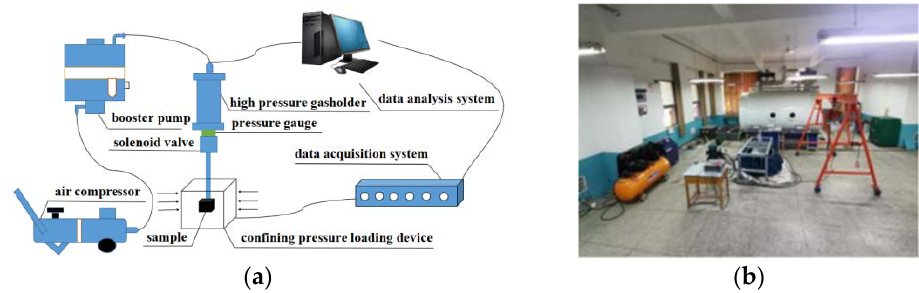
Figure 12. The HPAB experimental system: ( a ) schematic diagram; ( b ) physical picture.